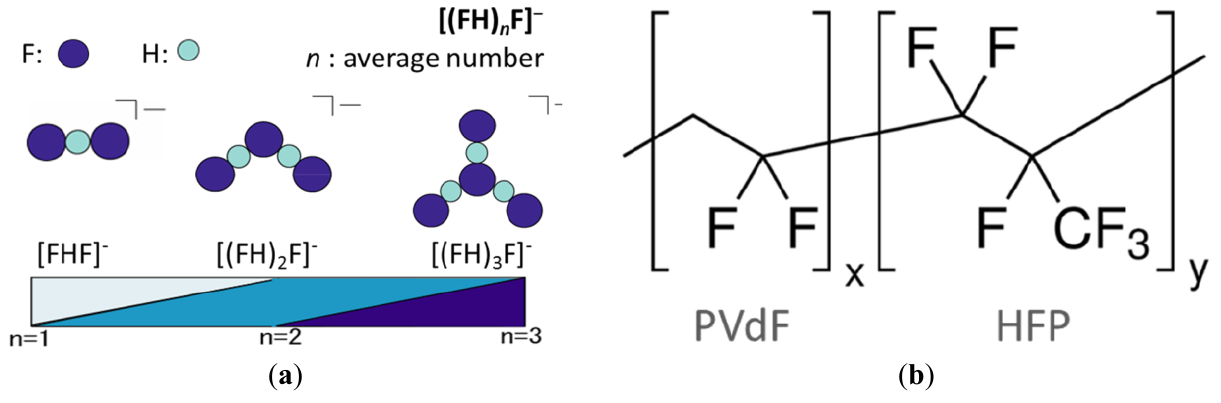
Figure 1. General chemical structures of ( a ) fluorohydrogenate anions and ( b )